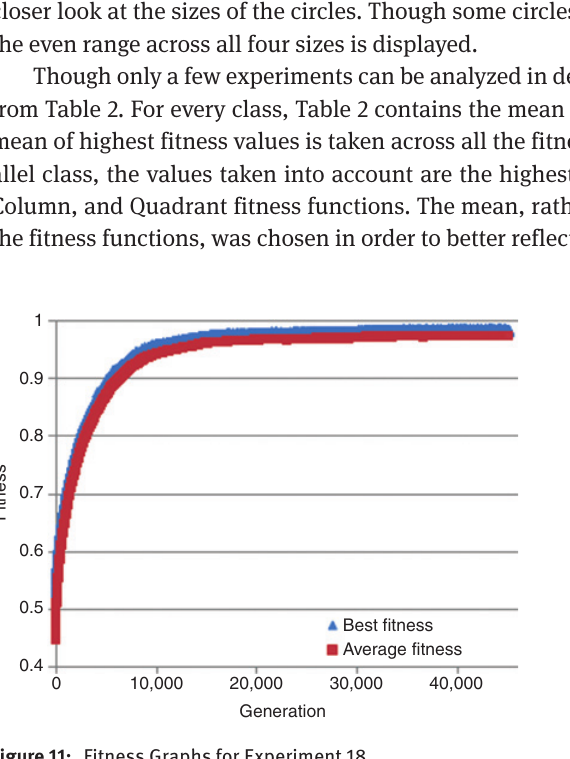
Figure 11: Fitness Graphs for Experiment